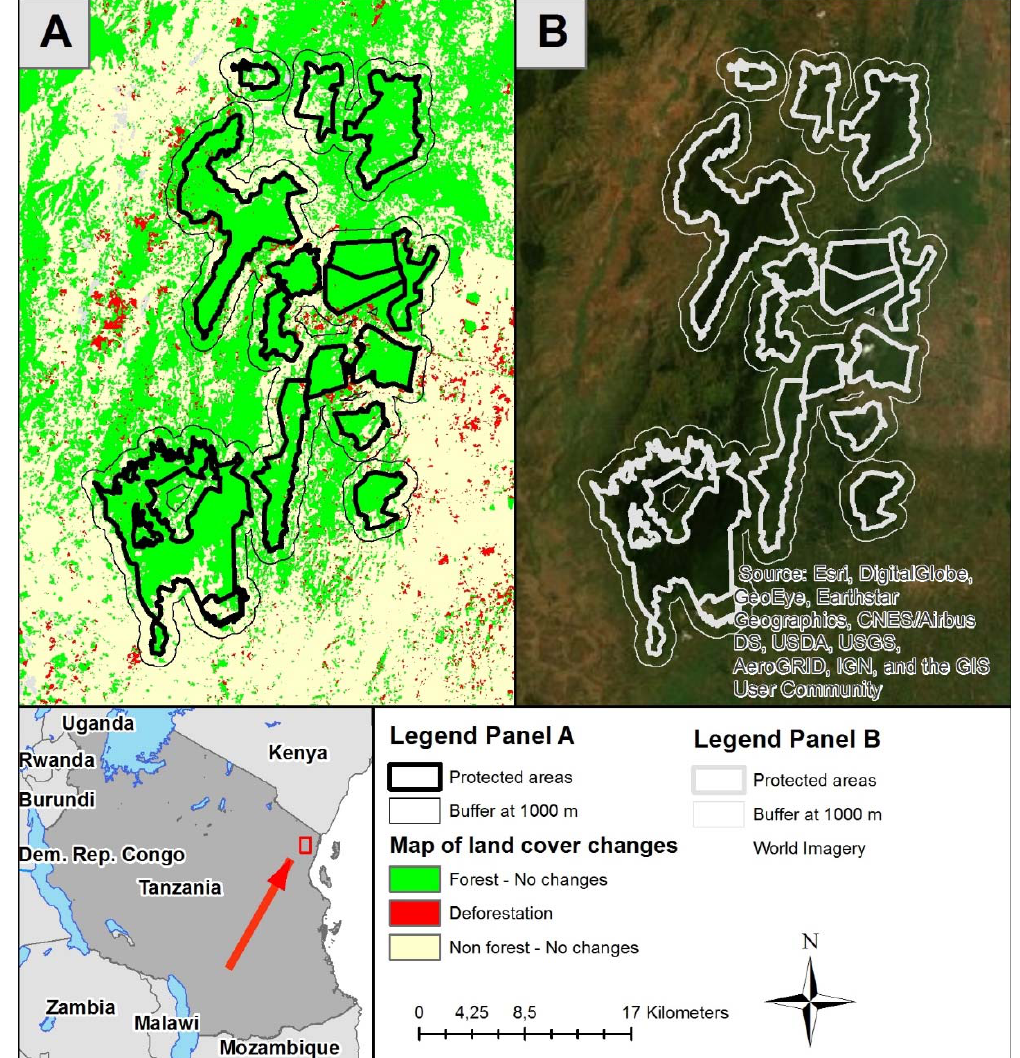
Figure 3. Series of PAs along the Usambara Mountains of northeastern Tanzania along the eastern most ranges of the Eastern Arc Mountains. Note: e ff ective protection with few spots or no deforestation inside and the bu ff er areas of the PAs. The bu ff er area in the figure is 1 km non-overlapping zone surrounding the PA network. Panel ( A ) is. of this study; and Panel ( B ) is image from space imagery providers.